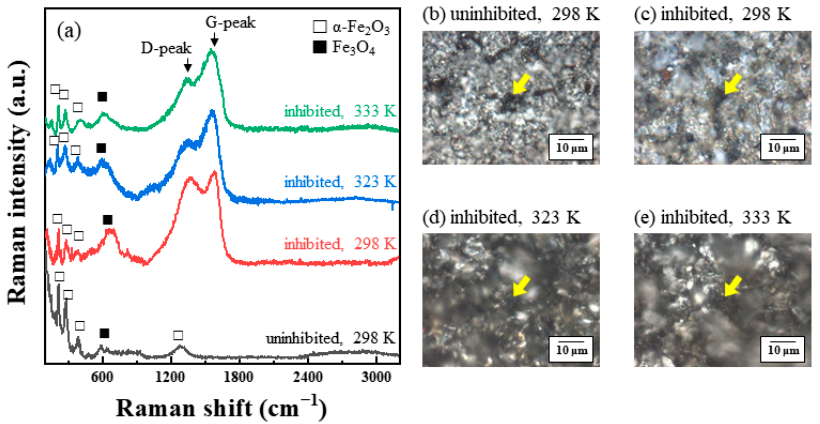
Figure 8. Raman spectra of ( a ) tea tree extract, ( b ) α -terpineol, ( c ) 1,8-cineole, and ( d ) terpinen-4-ol.